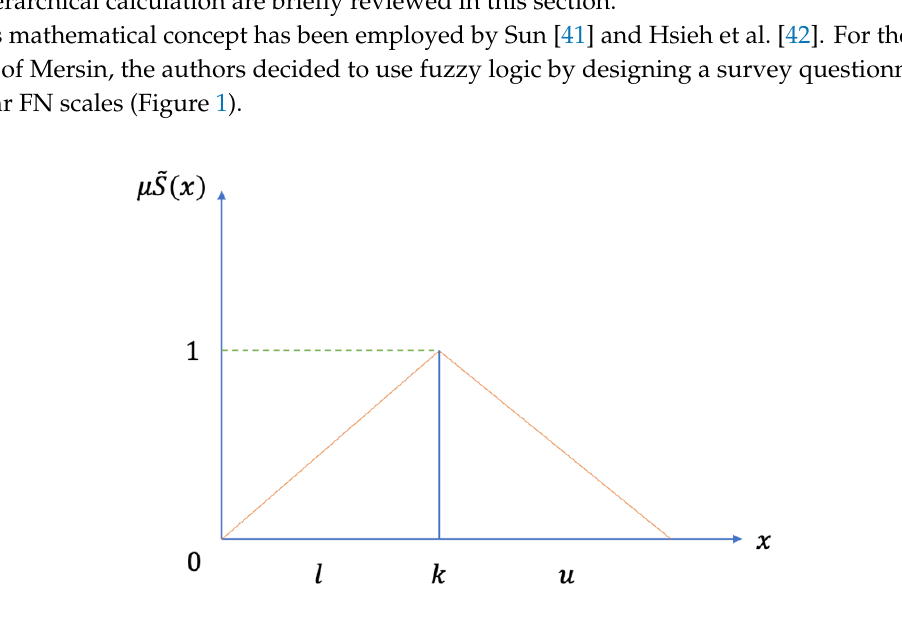
Figure 1. The membership functions of the triangular fuzzy numbers.